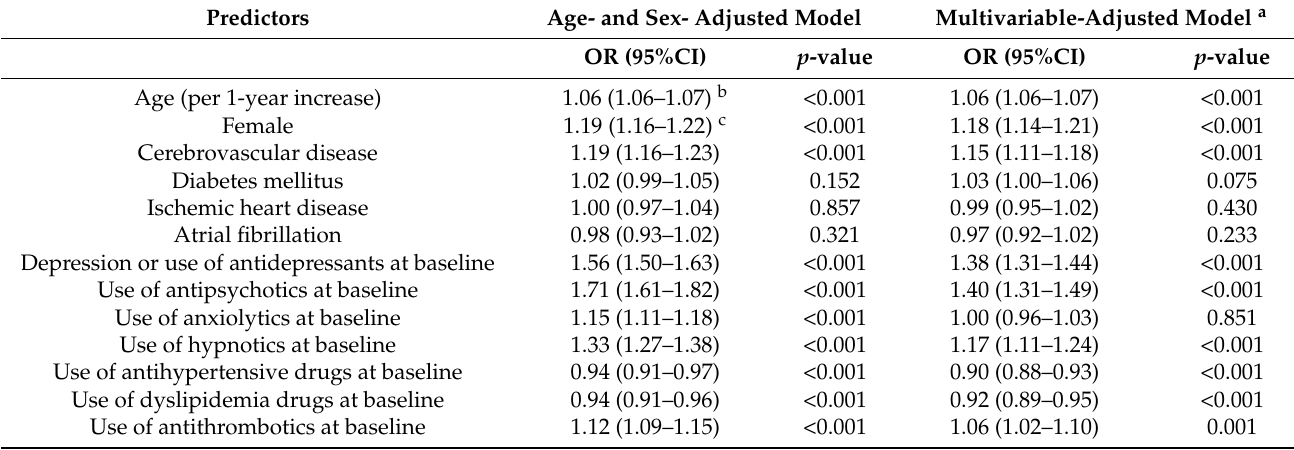
Table 3. Multivariable logistic regression analyses of predictors for new diagnosis of dementia.